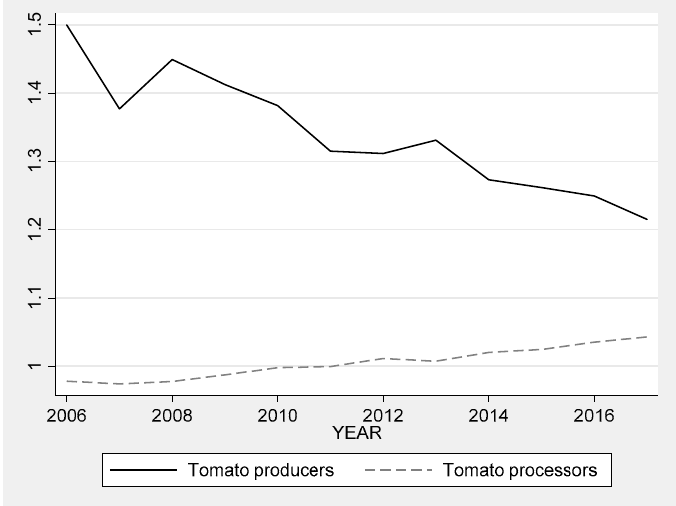
Figure 3. Development of returns to scale. Source: authors’ calculations.